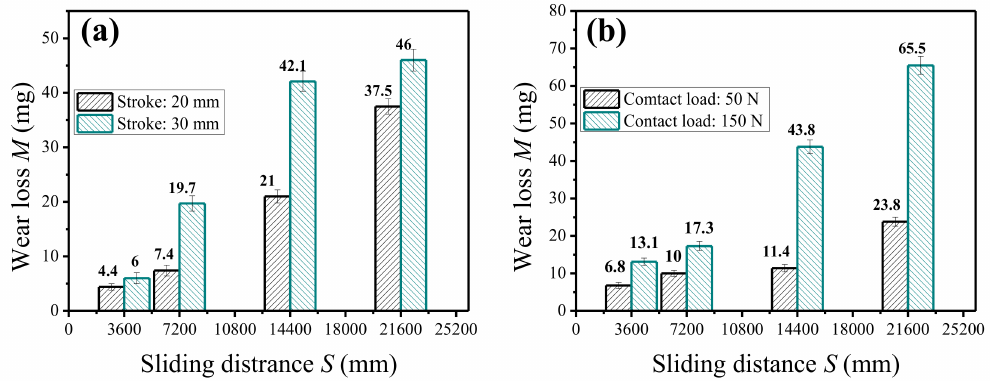
Figure 12. The evolution of wear mass loss for the wire rope under different conditions. ( a ) Stroke: 20 mm and 30 mm, load: 100 N; ( b ) load: 100 N and 150 N, stroke: 20